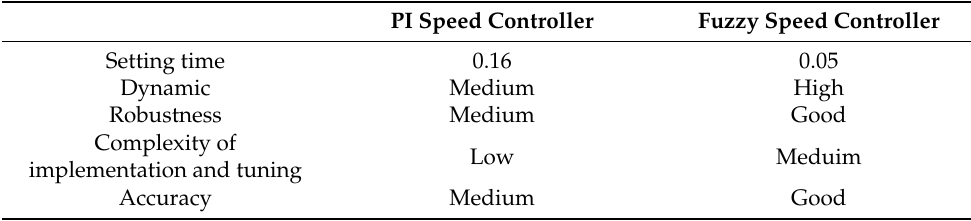
Figure 17. FDTC based fuzzy speed controller ( a ) rotor speed evolution, and ( b ) water flow. Table 7. Proposed fuzzy speed controller performances: A comparative study.